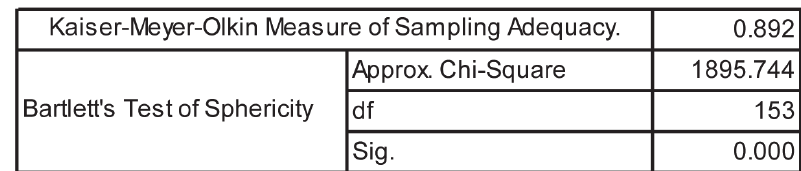
Table 6: KMO and Bartlett’s